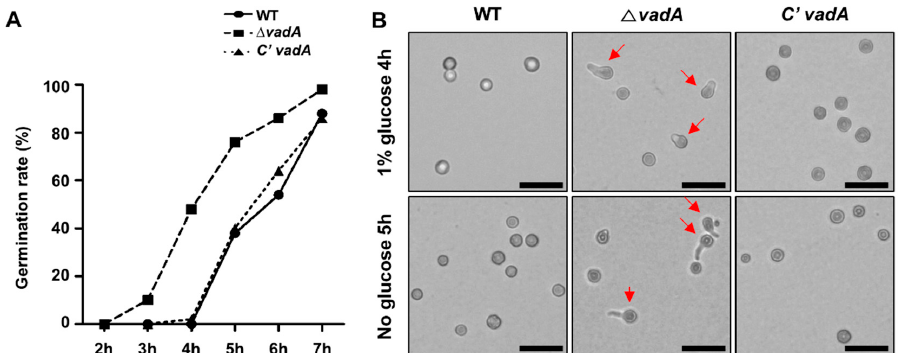
Figure 3. Role of vadA in germination. ( A ) Conidial germination rate in control (THS30), Δ vadA (THS33), and C’ vadA (THS34) conidia inoculated on solid minimal medium with glucose. ( B ) Control (THS30), Δ vadA (THS33), and C’ vadA (THS34) conidia were inoculated on solid MM (1% glucose), with or without a glucose source and incubated for 4 or 5 h, respectively (bar = 25 µm). Arrows indicate germ tubes.